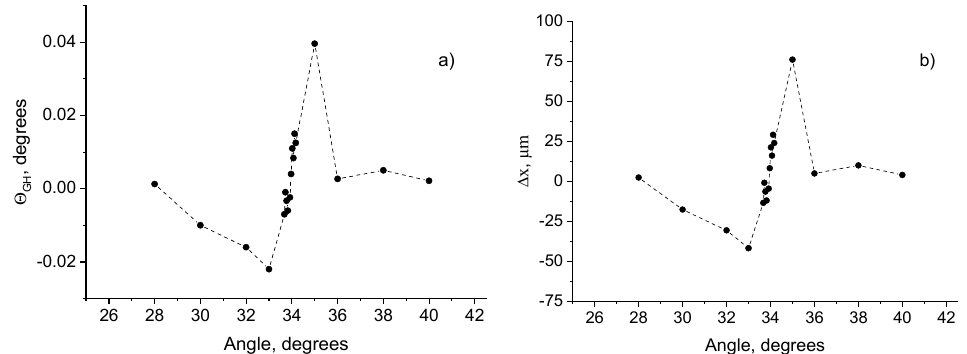
Figure 10. Calculated GH shifts (dots) as function of the incident angle: ( a )—angular shift; ( b )—GH shift at z = 11 cm. h = 40 nm; FWHM = 26.64 μ m.